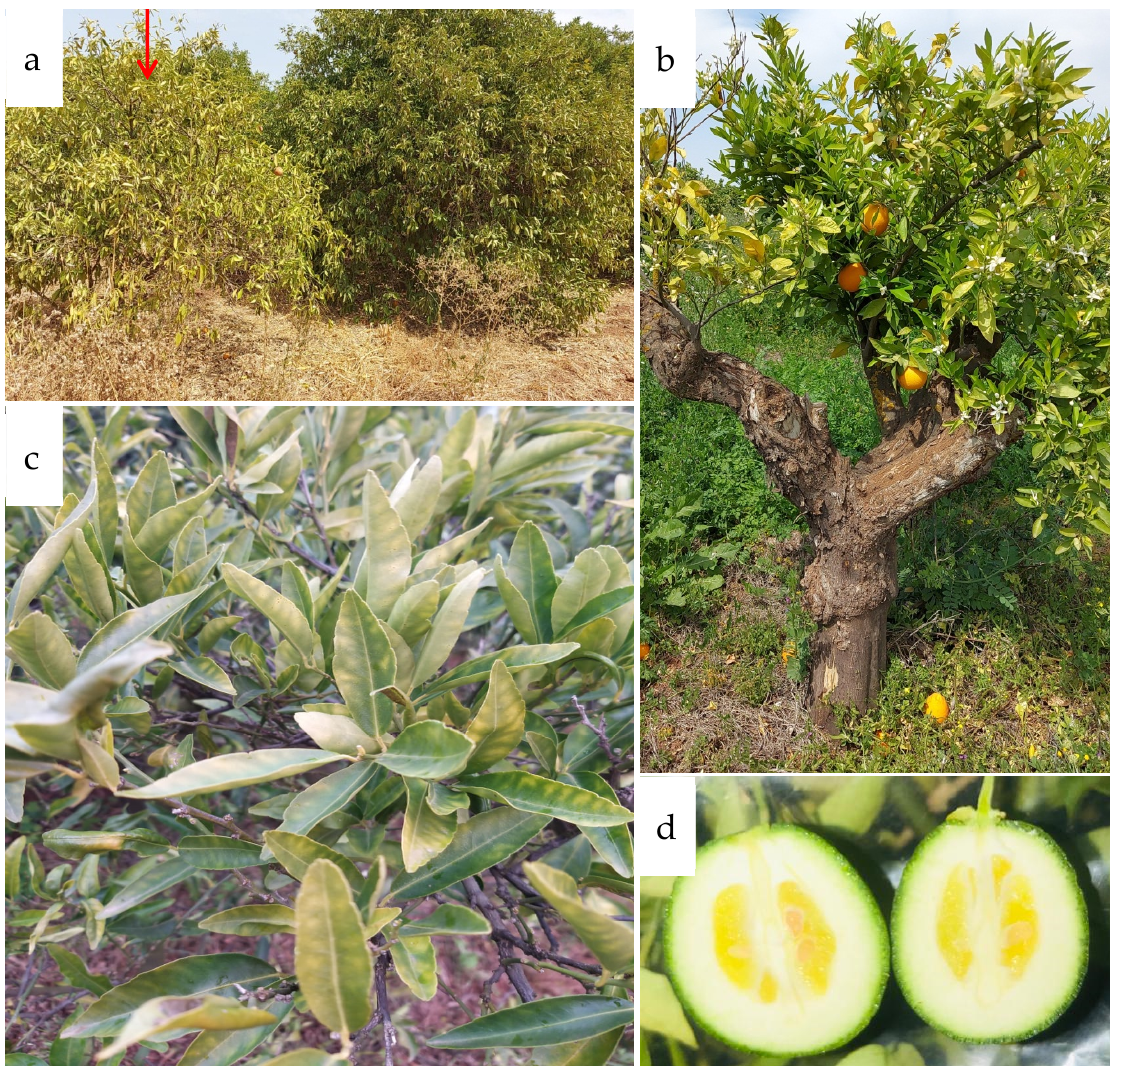
Figure 1. Field symptoms of citrus stubborn disease observed in Moroccan citrus orchards in the Tadla region (situated in the center of Morocco) in growing season 2021. ( a ) Compressed and stunted Navel sweet orange tree (red arrow); ( b ) clementine tree with different phenological stages; ( c ) Navel sweet orange leaves showing nutritional deficiency-like symptoms; ( d ) Navel sweet orange fruits with a gland shape.